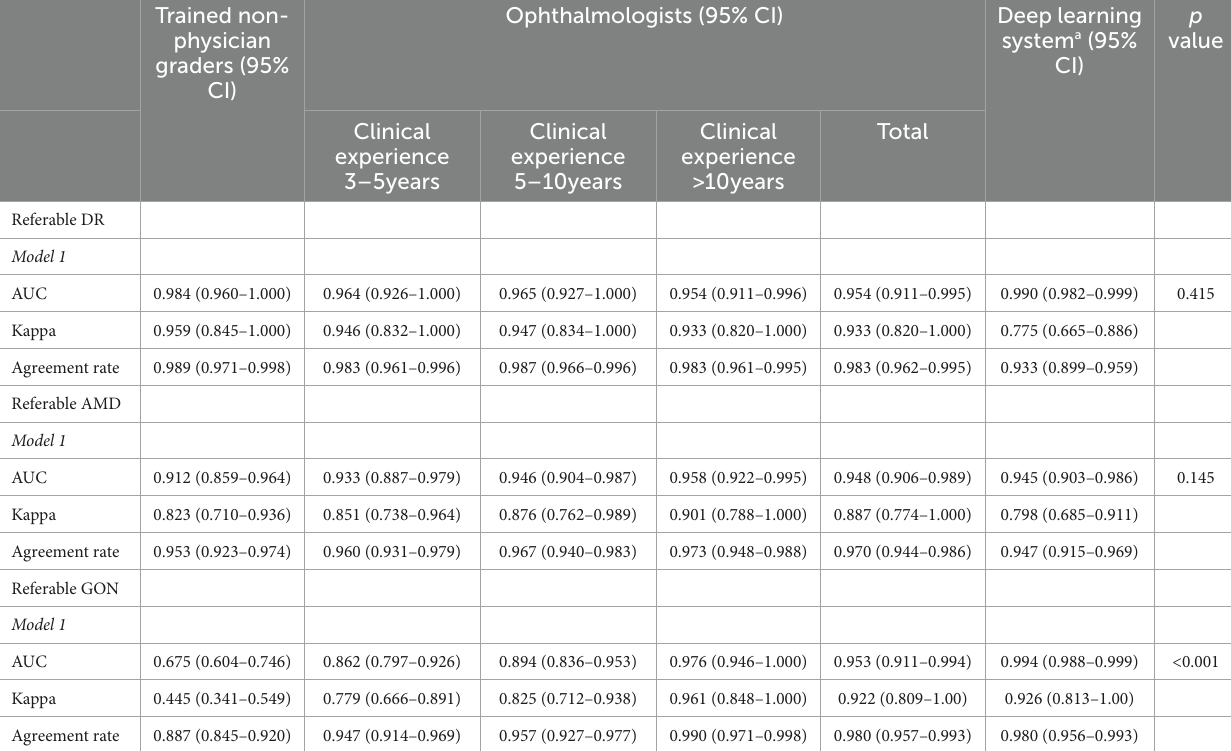
TABLE 3 Agreement of image interpretation by trained non-physician graders, general ophthalmologists, and deep learning system versus the expert consensus reference standard.